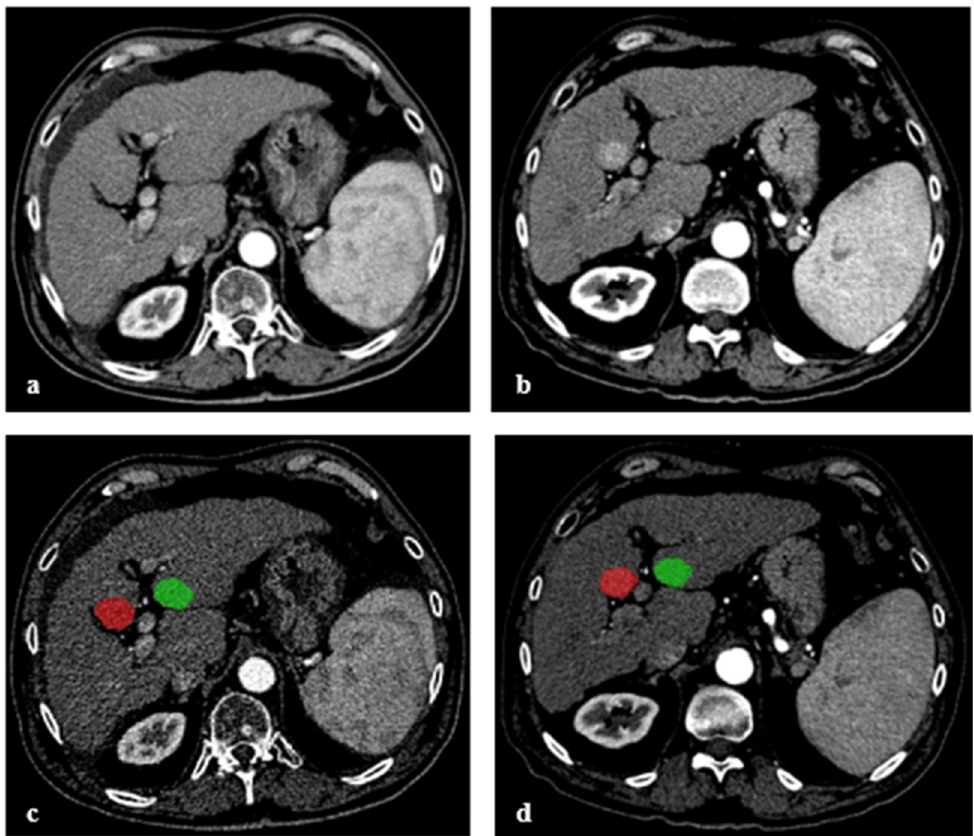
Figure 2. Arterial phase computed tomography of a cirrhotic patient with no visually detectable lesion on initial CT (PRE-CT) ( a ). CT 6 months later (FU-CT) shows a newly emerged HCC lesion in liver segment V ( b ). Segmentations used for the analysis in arterial phase images of PRE-CT ( c ) and FU-CT ( d ). Segmentations were first drawn around the visible border of HCC in FU-CT and subsequently in the corresponding region in PRE-CT, shown in red. As a negative control, a segmentation comparable in size and shape was drawn in PRE-CT and FU-CT in a region without manifestation of HCC, shown in